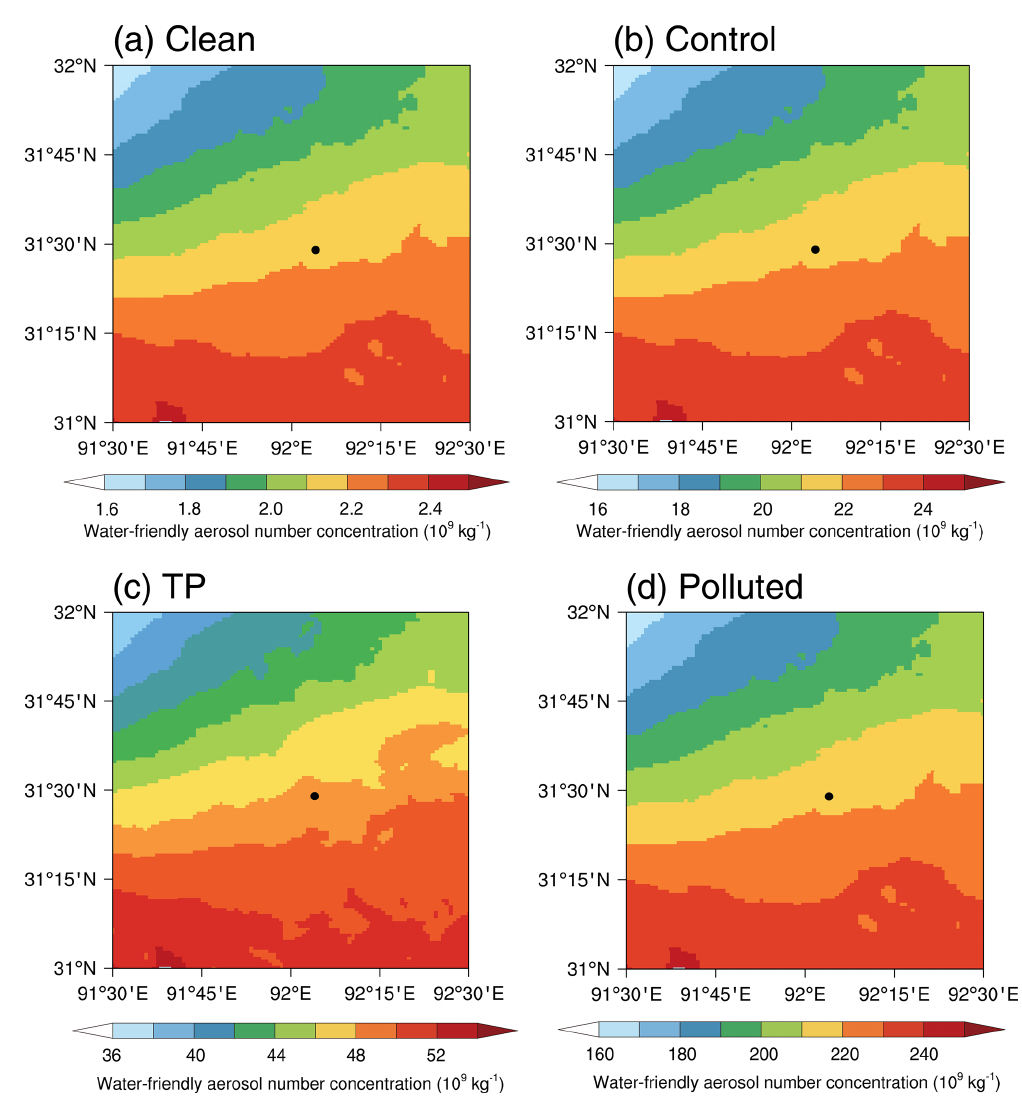
Figure 4. Vertically averaged water-friendly aerosol number concentration from (a) clean, (b) control, (c) TP, and (d) polluted cases at 00:00UTC on 24 July 2014 in the 1 ◦ × 1 ◦ area around Naqu (31–32 ◦ N, 91.5–92.5 ◦ E; area B). The dot represents the position of